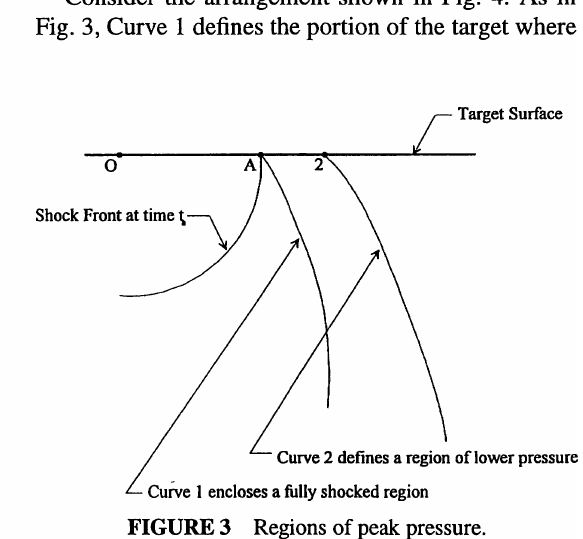
FIGURE 3 Regions of peak: